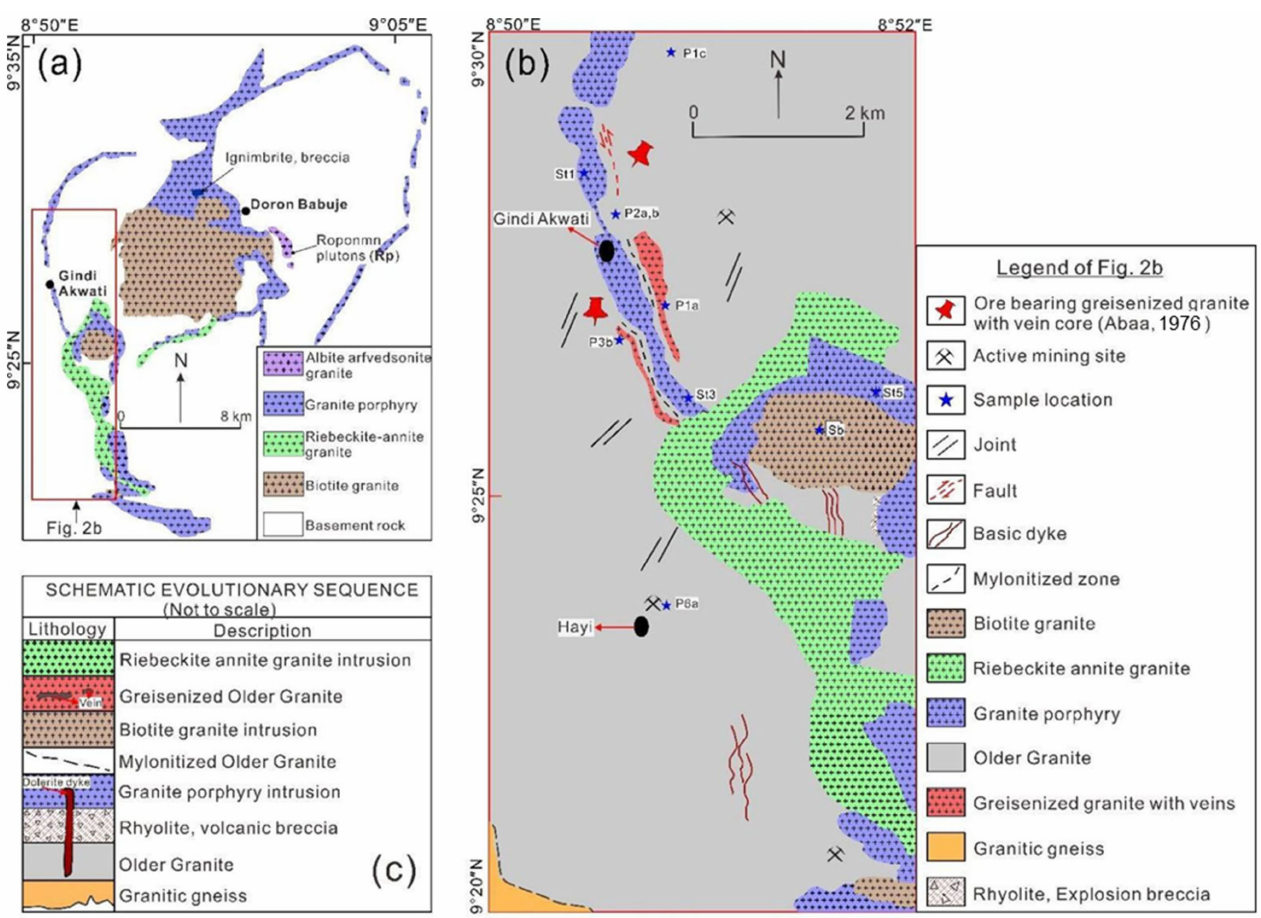
Figure 2. ( a ) Simplified geological map of Ropp Complex showing the distribution of plutons (Modified after [10]); ( b ) Geological map of the western edge of Ropp Complex, where the Gindi Akwati deposit is located; ( c ) Schematic evolution sequence of rocks around the Gindi Akwati deposit, north-central